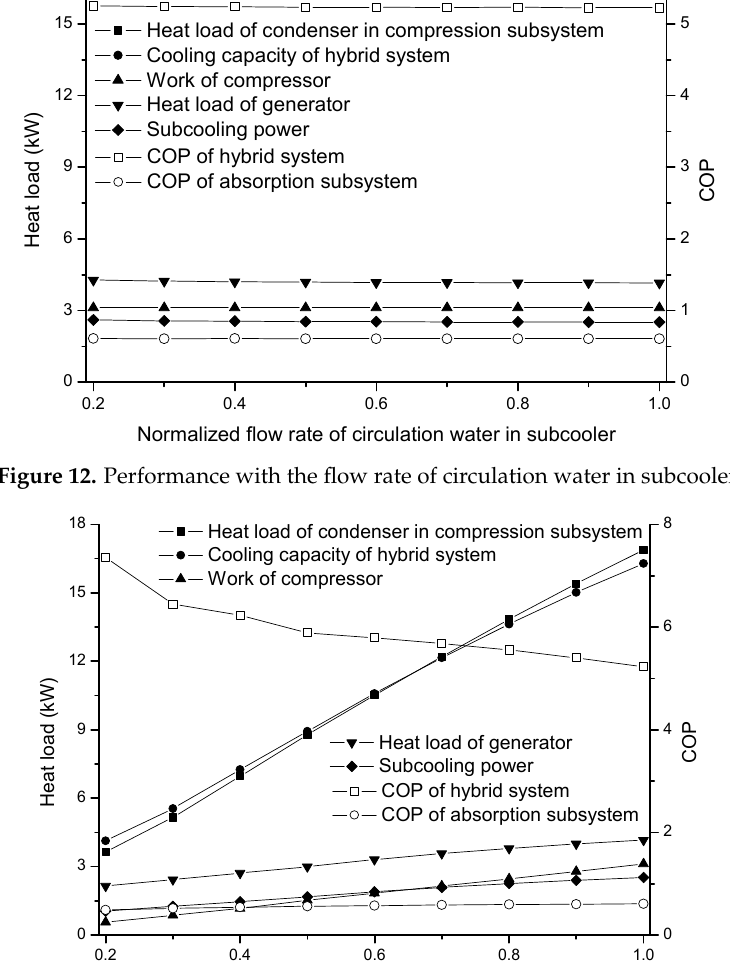
Figure 13. Performance with the speed of the compressor.